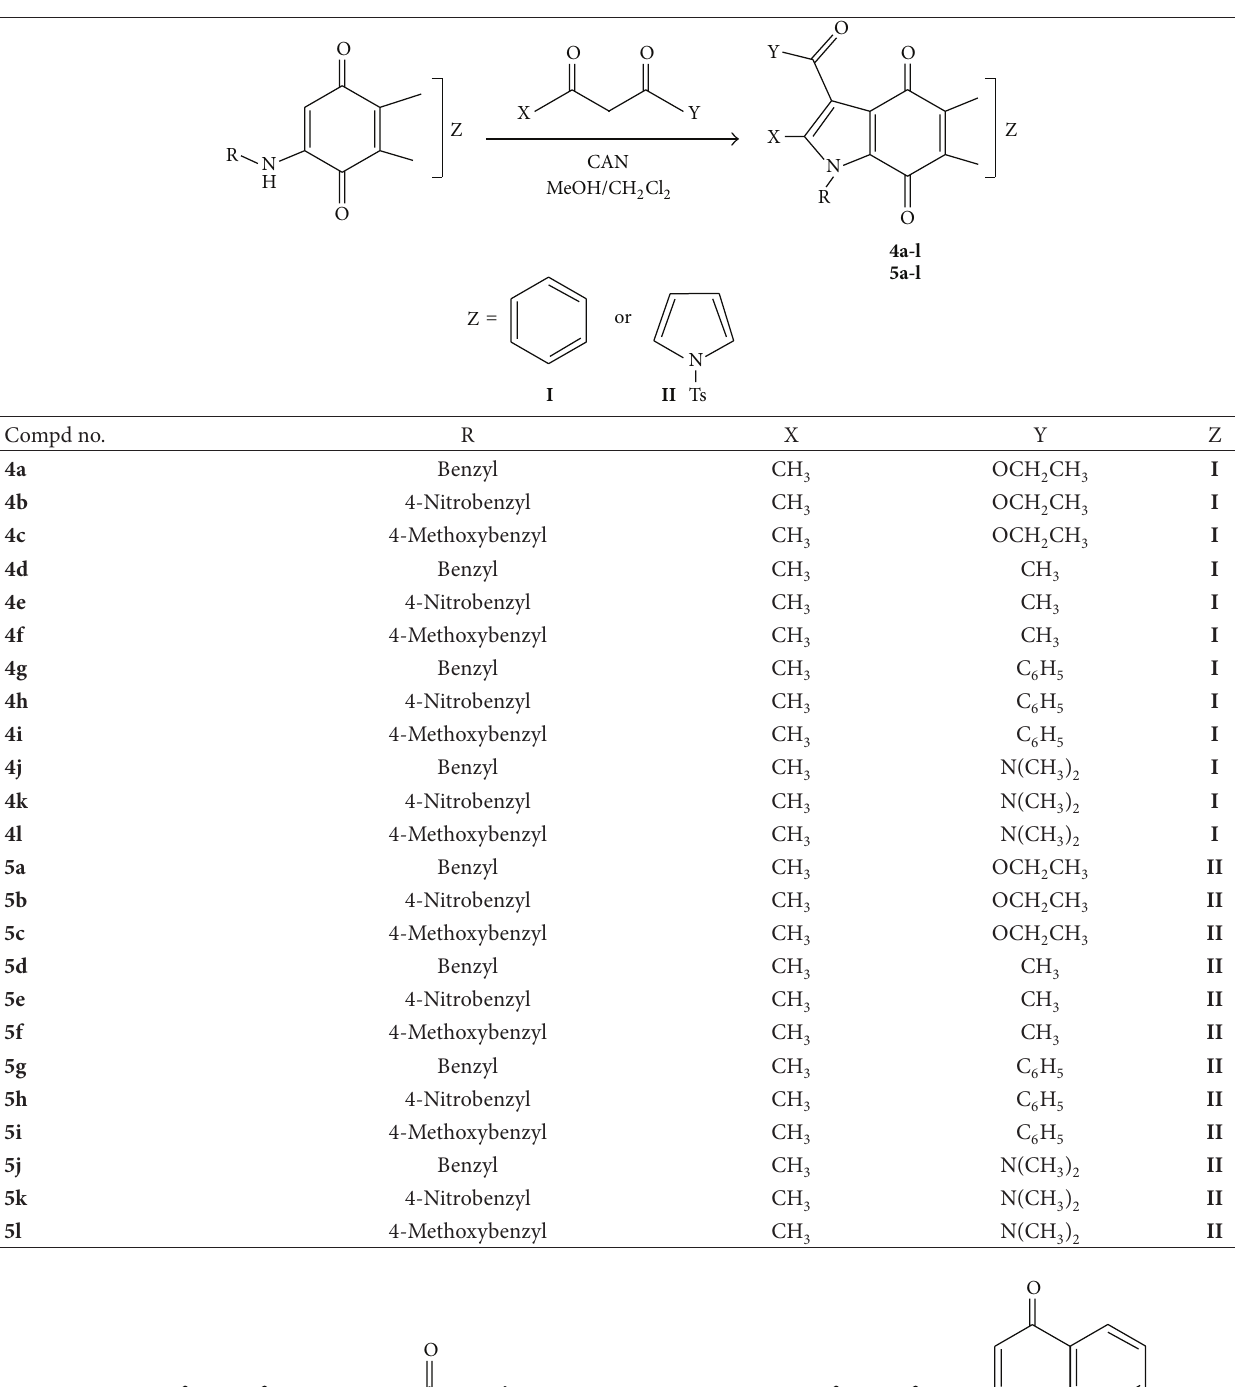
Table 1: General scheme for the oxidative free radical cyclization.